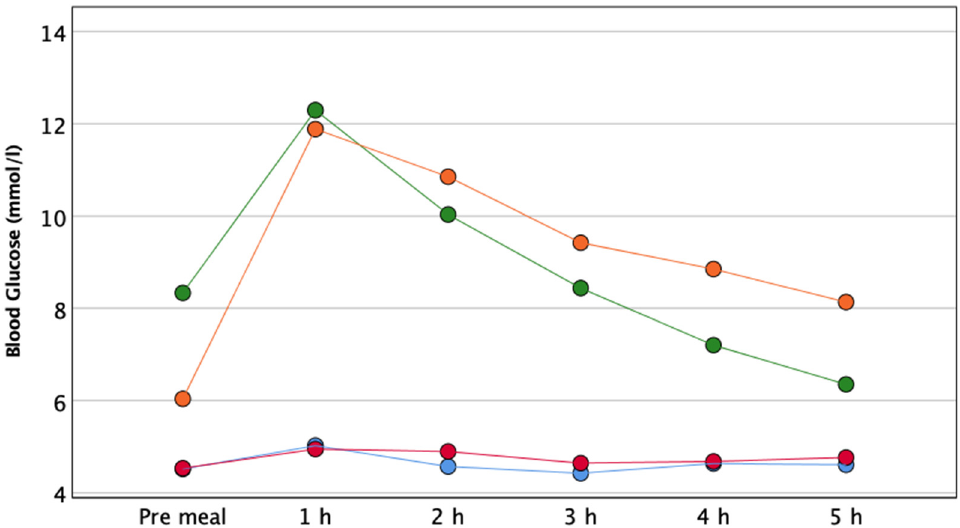
Figure 2. Blood glucose at pre-meal, 1 h, 2 h, 3 h, 4 h, 5 h after the two test meals in T1D and healthy controls. Green and orange represent T1D after EVOO- and butter-enriched meals; blue and red represent controls after EVOO- and butter-enriched meals.